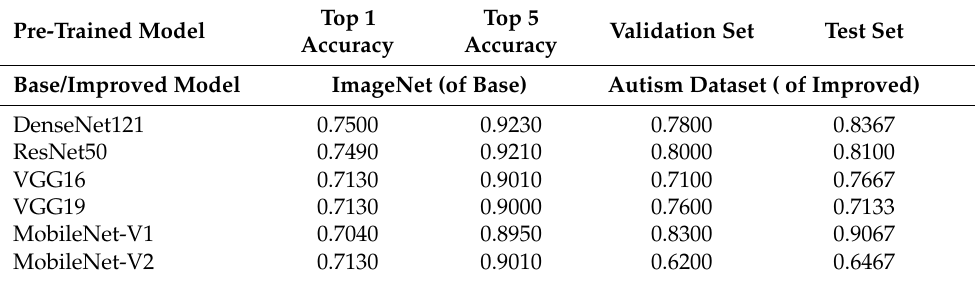
Table 3. The Accuracy of Individual Pre-trained Models for Imagenet (of Base Models) and Autism Facial Dataset (of Improved